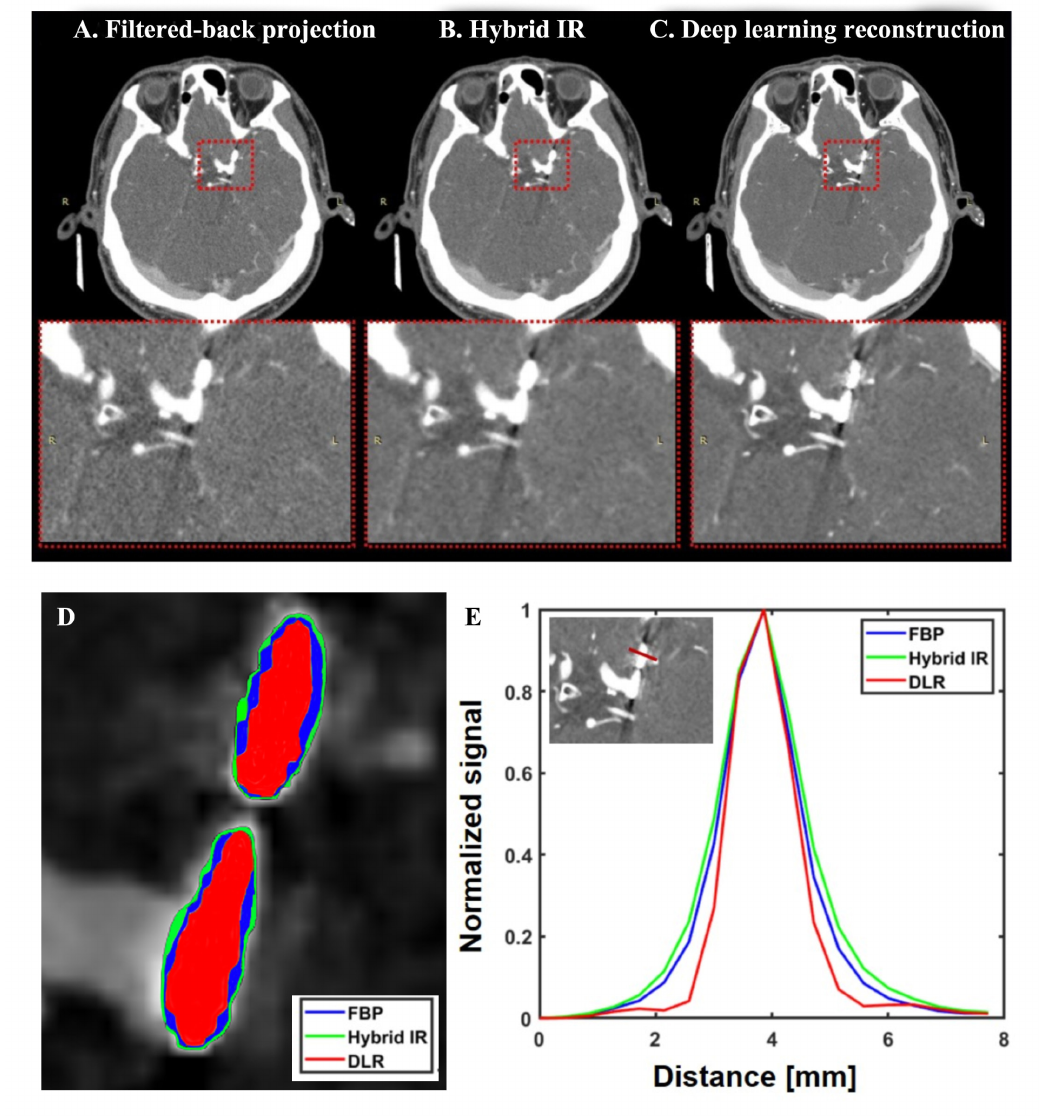
Fig. 4. Examples of brain CT angiographic scan for surgically clipped left paraclinoid aneurysms. The blooming artifact from surgically clips de- creased in the deep learning reconstruction (DLR) (C) than hybrid iterative reconstruction (IR) (B) and filtered-back projection (FBP) (A). The surgical clip can be seen on the magnified images with the red dashed outline for FBP, Hybrid IR, and DLR. The subjective score of images qualified from two observers on deep learning reconstruction (score 4) was higher than hybrid iterative reconstruction (score 3) and filtered back projection (score 3). The use of DLR resulted in sharper images with reduction of blooming artifact compared to FBP and Hybrid IR when considering the analysis of perimeter (D) and normalized profile curve of 10–90% edge rise distance